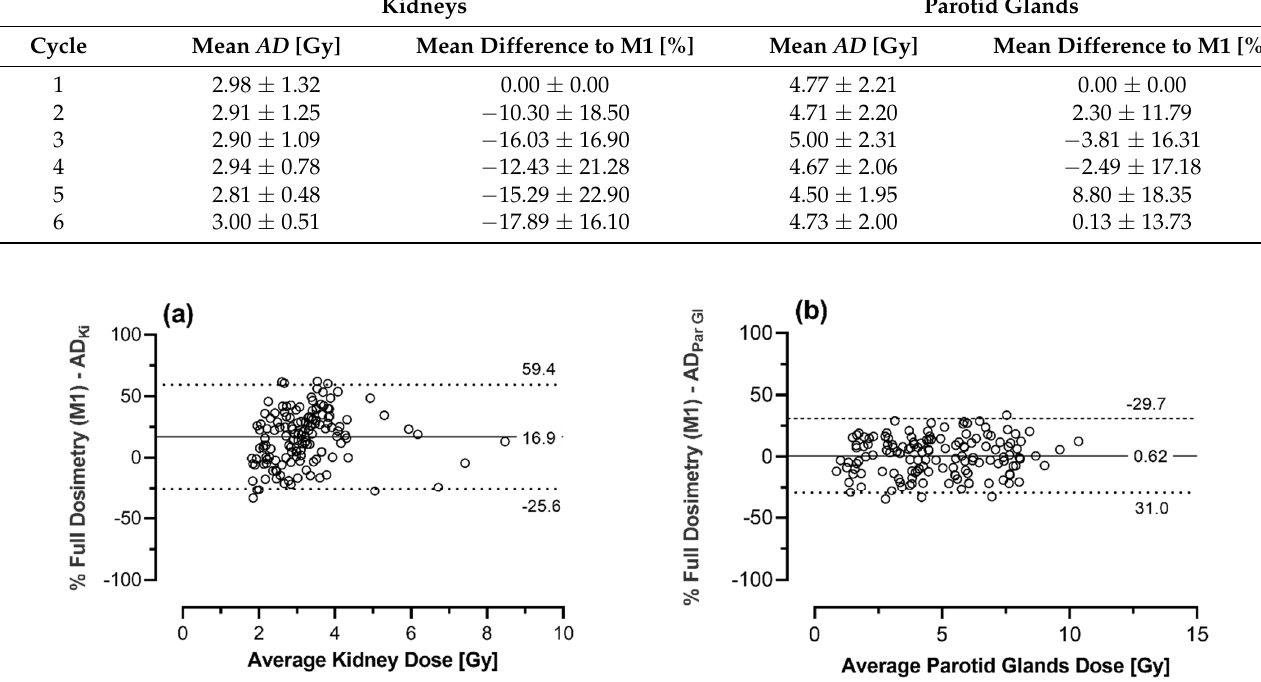
Figure 4. Bland-Altman-analysis comparing calculated absorbed doses using full dosimetric scheme (method 1, used as reference) and dosimetry based on calculated absorbed doses of cycle 1 and adaptation for applied activities (method 3) for kidneys ( a ) and parotid glands ( b ). The solid line shows the mean bias between the two methods whereas dotted lines show the 95% limits of agreement.